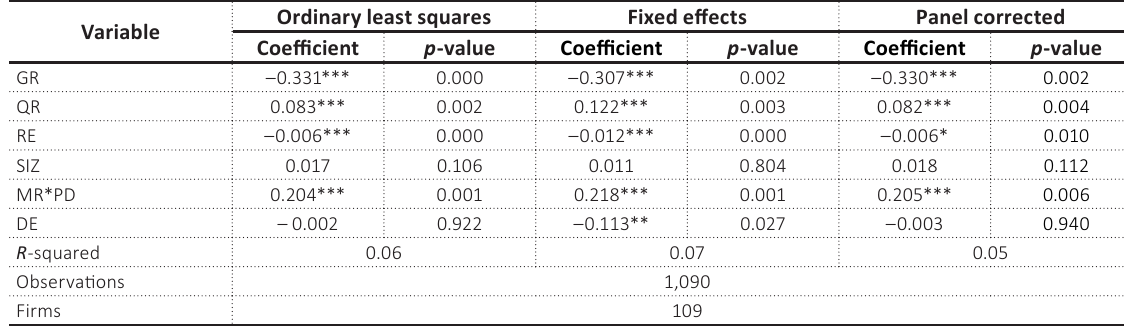
Source: Authors’ computation using STATA